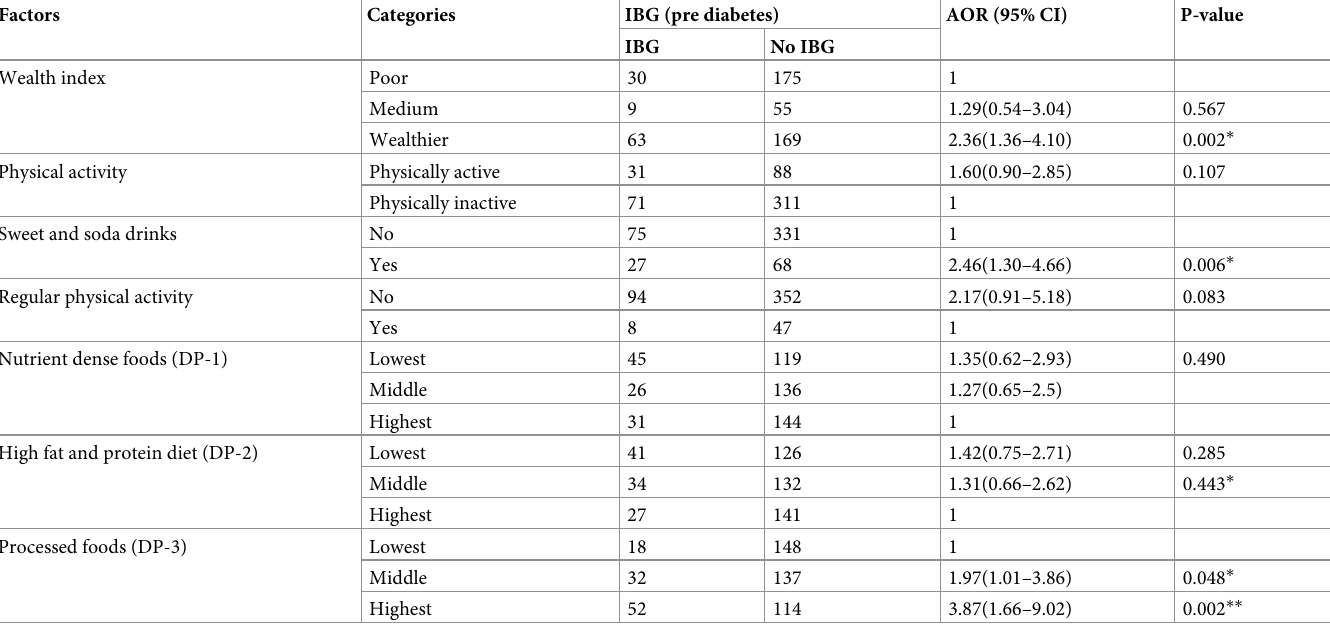
Table 5. Adjusted multivariable logistic regression showing factors associated with IBG among adults residing in Dire Dawa and Harar, Eastern